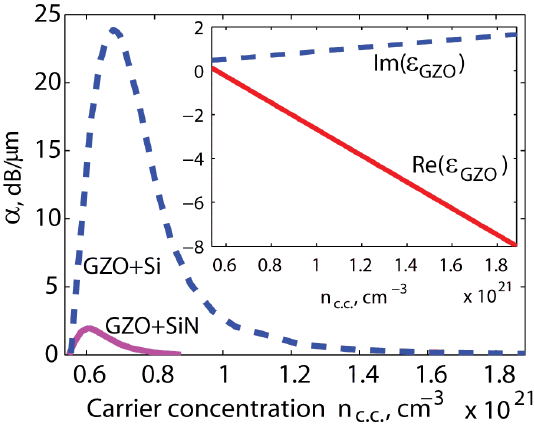
Figure 13: Increase of the absorption coeflcient in a multilayer waveguide for the carrier concentration, which provides small neg- ative permittivities (see inset), required for acquiring the plasmonic resonance at the working frequencies. Multilayer structures with the high-index claddings, for example silicon, give much higher val- ues of changes in the absorption coeflcient, i.e. ER, in comparison to the low-index claddings [113].